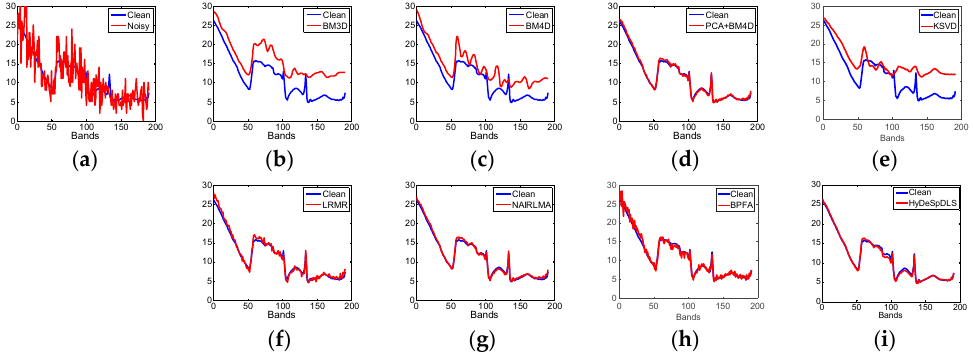
Figure 7. Denoised spectral signature results of Washington DC Mall data with Poissonian noise: ( a ) Noisy; ( b ) BM3D; ( c ) BM4D; ( d ) PCA + BM4D; ( e ) KSVD; ( f ) LRMR; ( g ) NAILRMA; ( h ) BPFA; and ( i ) HyDeSpDLS.